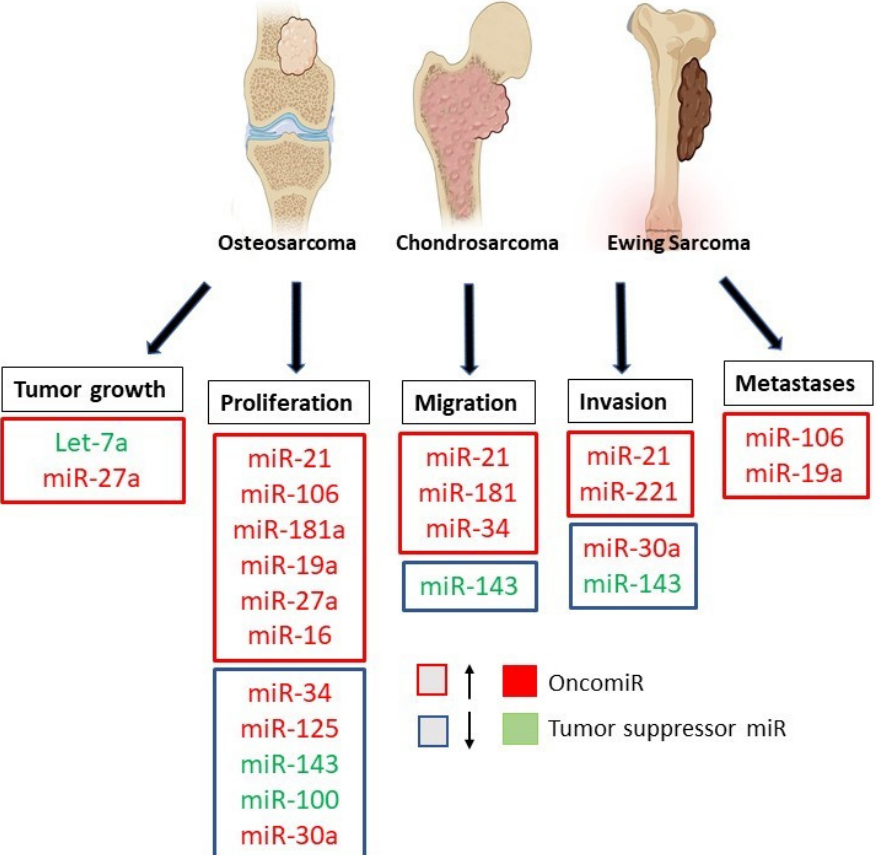
Figure 4. Role of microRNAs in Osteosarcoma, Ewing’s Sarcoma, and Chondrosarcoma. The figure summarizes the down-regulated and up-regulated miRNAs involved in the progression, invasion, and metastasis of bone